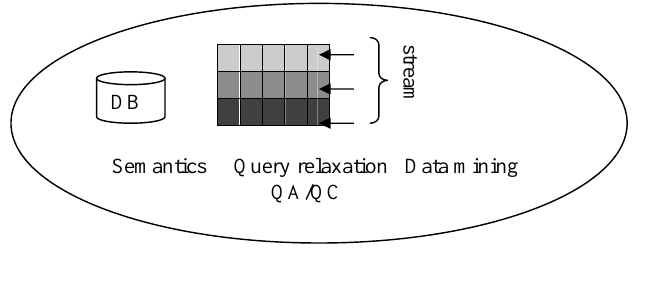
Figure 3. Smart query system